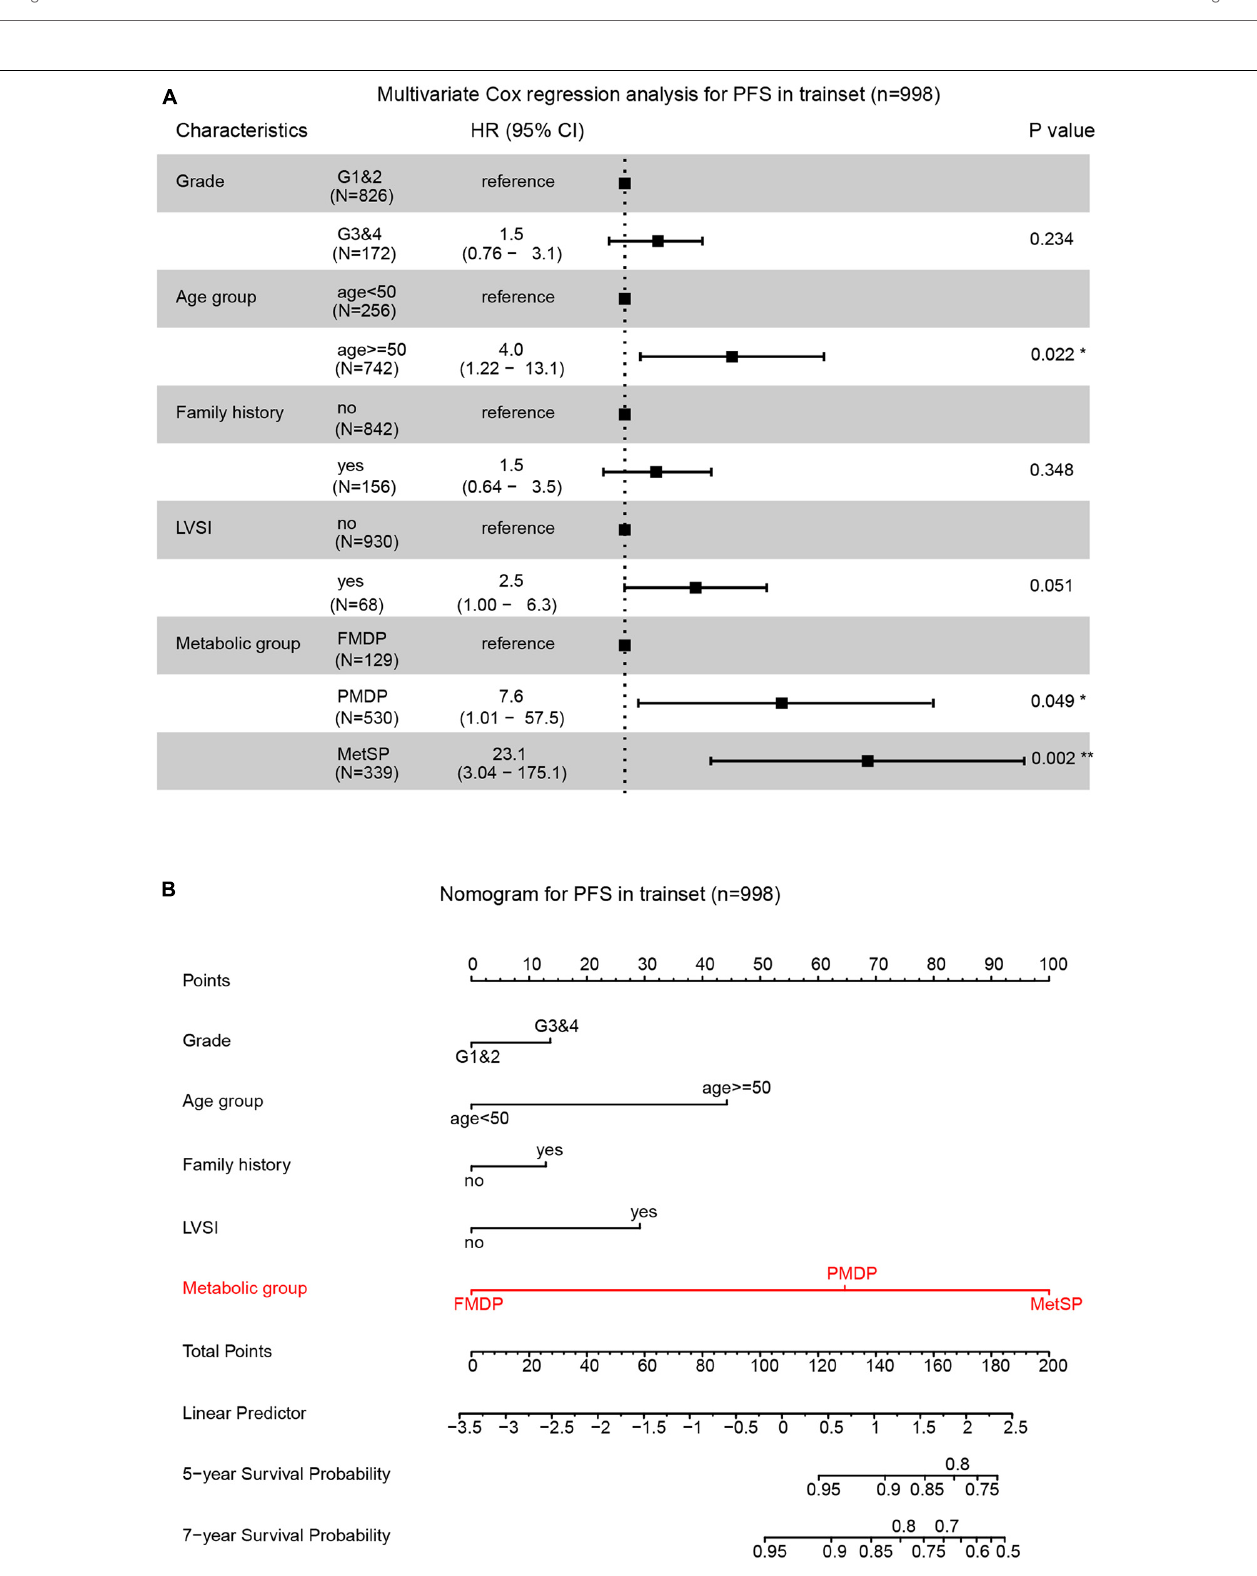
FIGURE 2 | Partial metabolic disorder patient (PMDP) was an independent risk factor in predicting early-stage EEC prognosis. (A) A forest plot of the multivariate Cox regression analysis showed PMDPs and metabolic syndrome in patients (MetSPs) were significantly associated with shorter PFS. (B) A nomogram was built by integrating pathologic grade, age group, family history, lymph-vascular space invasion (LVSI), and metabolic group and indicated the robust predicting ability of the metabolic group.